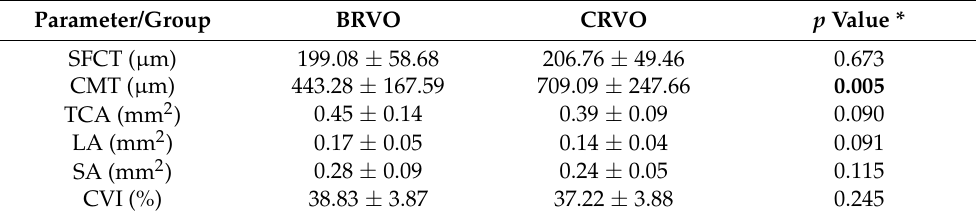
Table 5. Optical coherence tomography parameters according to type of retinal vein occlusion.